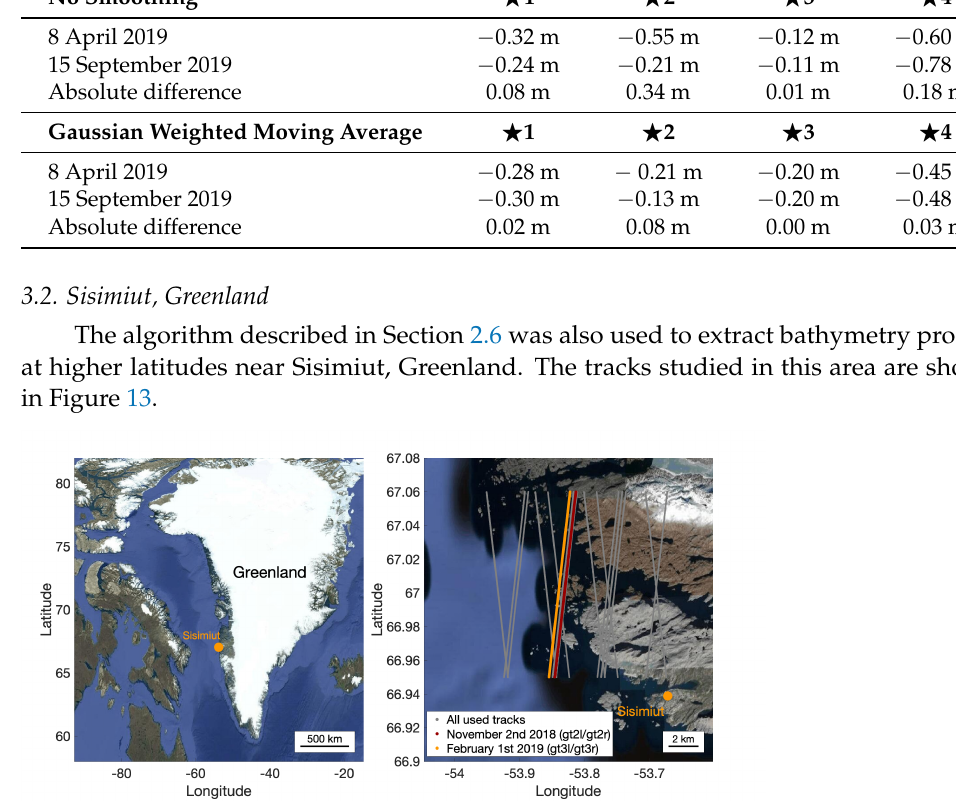
Figure 13. ( Left ) Location of Sisimiut, Greenland. ( Right ) The different ICESat-2 beams used for this